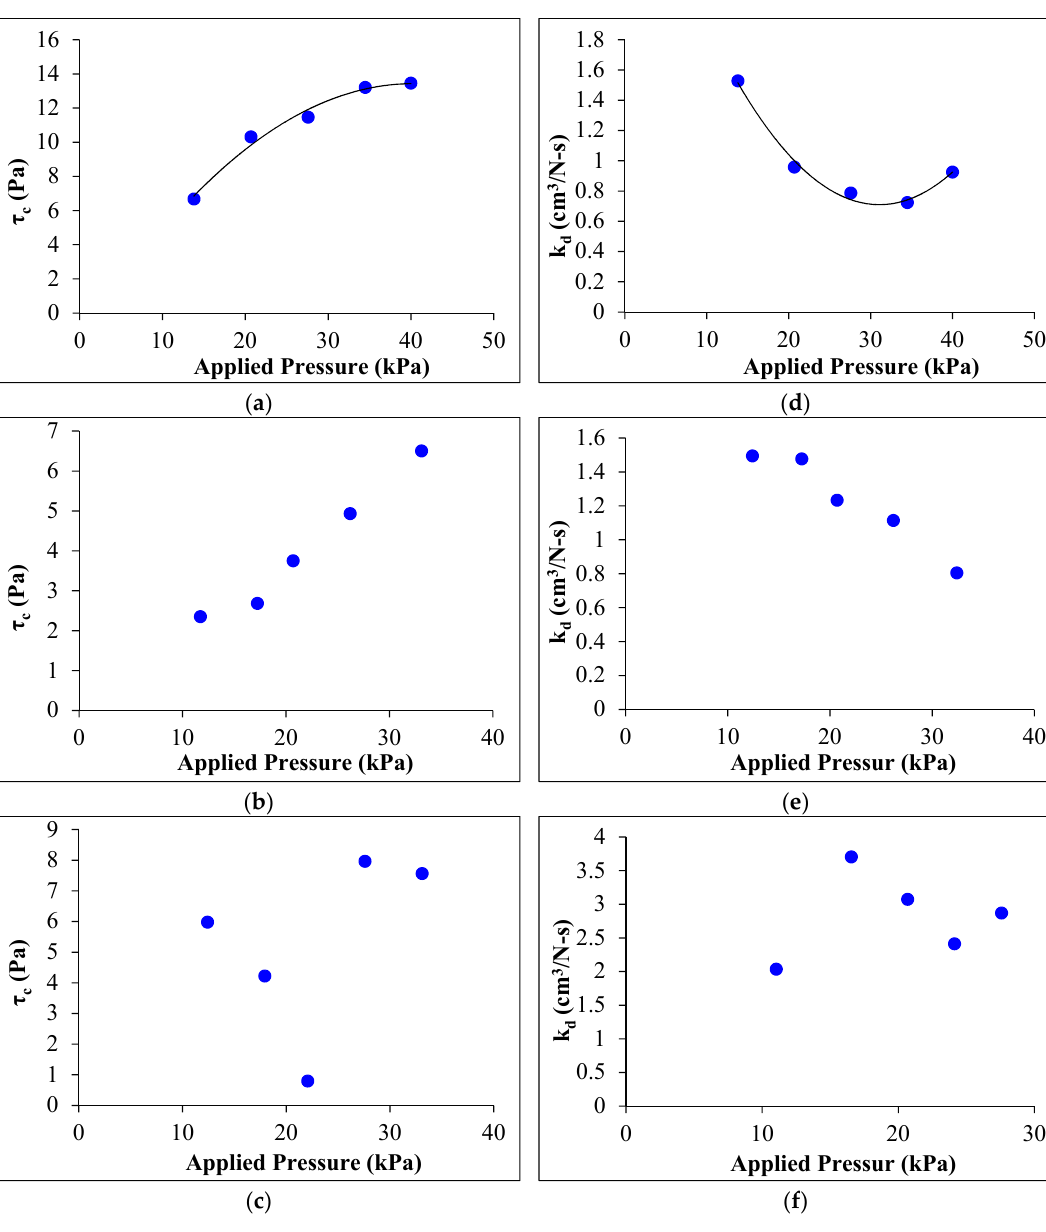
Figure 2. Response patterns of critical shear stress ( τ c ) and erodibility coefficient ( k d ) to jet-test device pressure head setting. Data represented are identified for τ c : ( a ) concave-down shape, ( b ) linear, ( c ) e scattered points and for k d : ( d ) concave-up shape, ( e ) linear, and ( f ) scattered points.